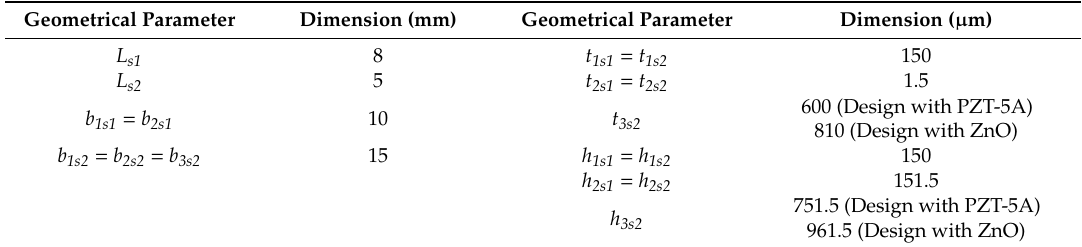
Table 1. Geometrical parameters and dimensions of the PEH devices.